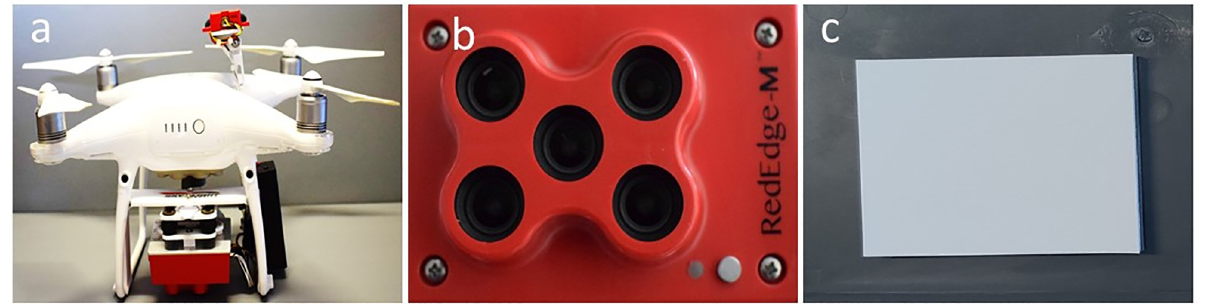
Fig 3. (a) Phatom-4 drone mounted with MicaSense RedEdge-M camera, (b) MicaSense RedEdge-M camera, and (c) Reflectance panel for radiometric calibration.